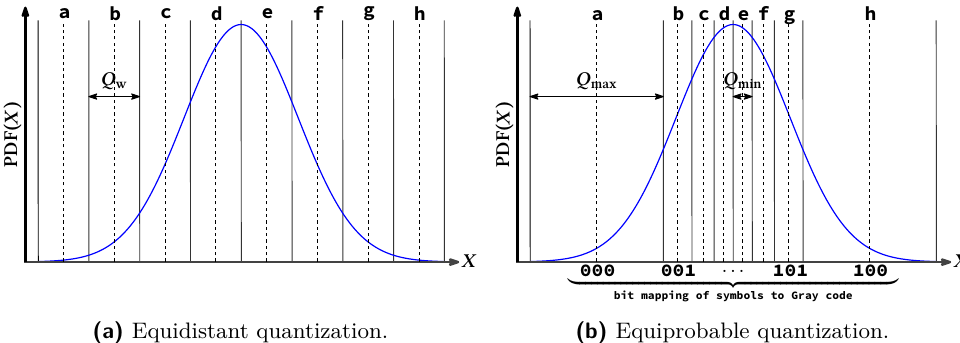
Figure 2: Visualization of equiprobable and equidistant quantization schemes processing PDF( X ) which follows N ( µ X , σ X ) based on the parameters given in